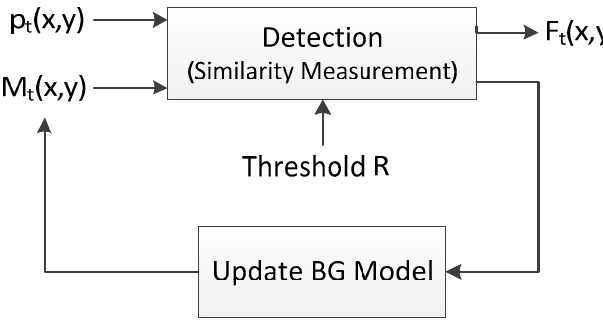
Figure 1. Paradigm of Background Subtraction.